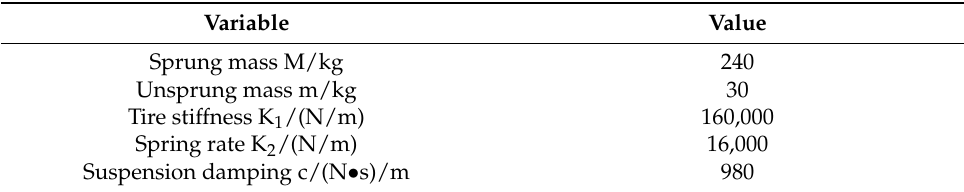
Table 2. Fundamental data of suspension system.